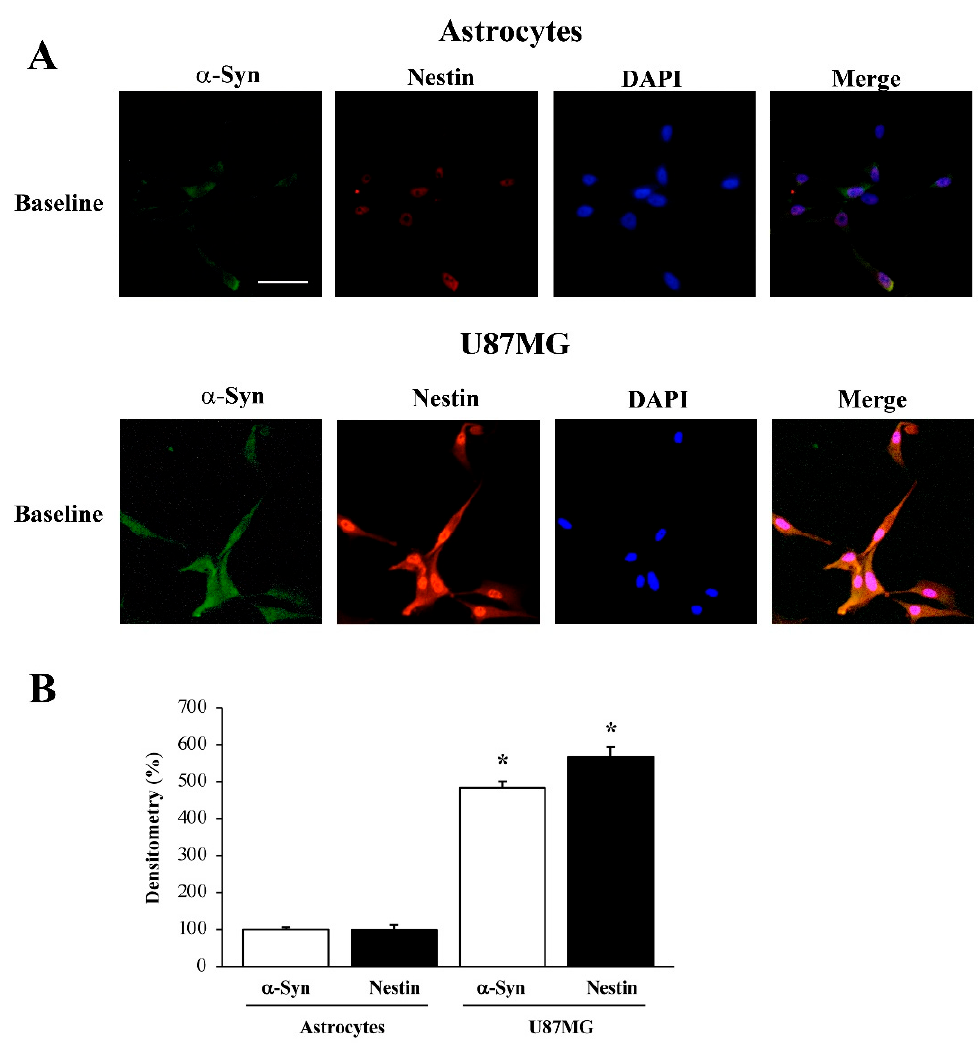
Figure 2. α -Syn and nestin immuno-fluorescence within astrocytes and GBM cells in baseline conditions. ( A ) Representative pictures show immuno-fluorescence and merging of α -syn (green) and nestin (red) within astrocytes (upper panels) and GBM cells (lower panels). Nuclei are stained with DAPI (blue). Densitometry of both antigens is reported in the graph ( B ). Data are given as the mean percentage ± S.E.M. of optical density for each experimental group (densitometry in astrocytes is considered as 100%) obtained from N = 30 cells per group. * p < 0.05 compared with astrocytes. Scale bar = 24 μ m.